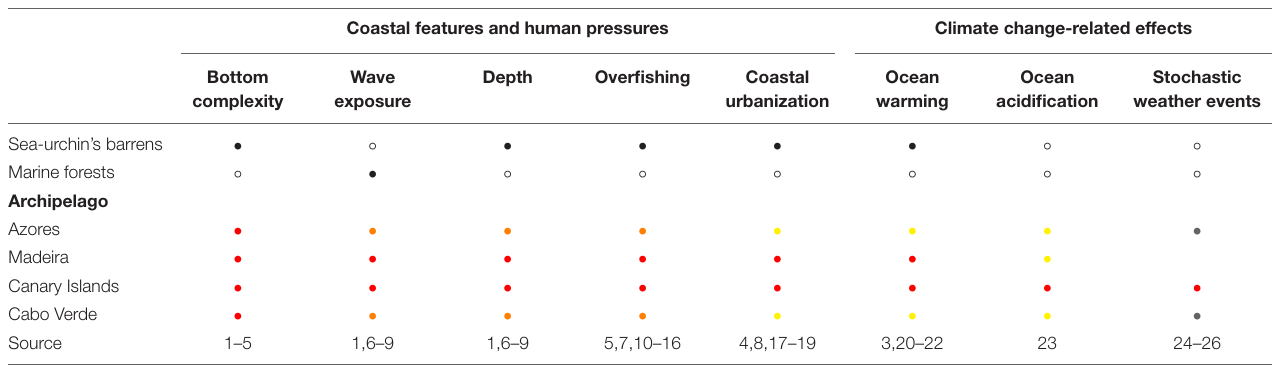
TABLE 1 | Interactions of discussed drivers and impacts over marine forests and sea-urchin